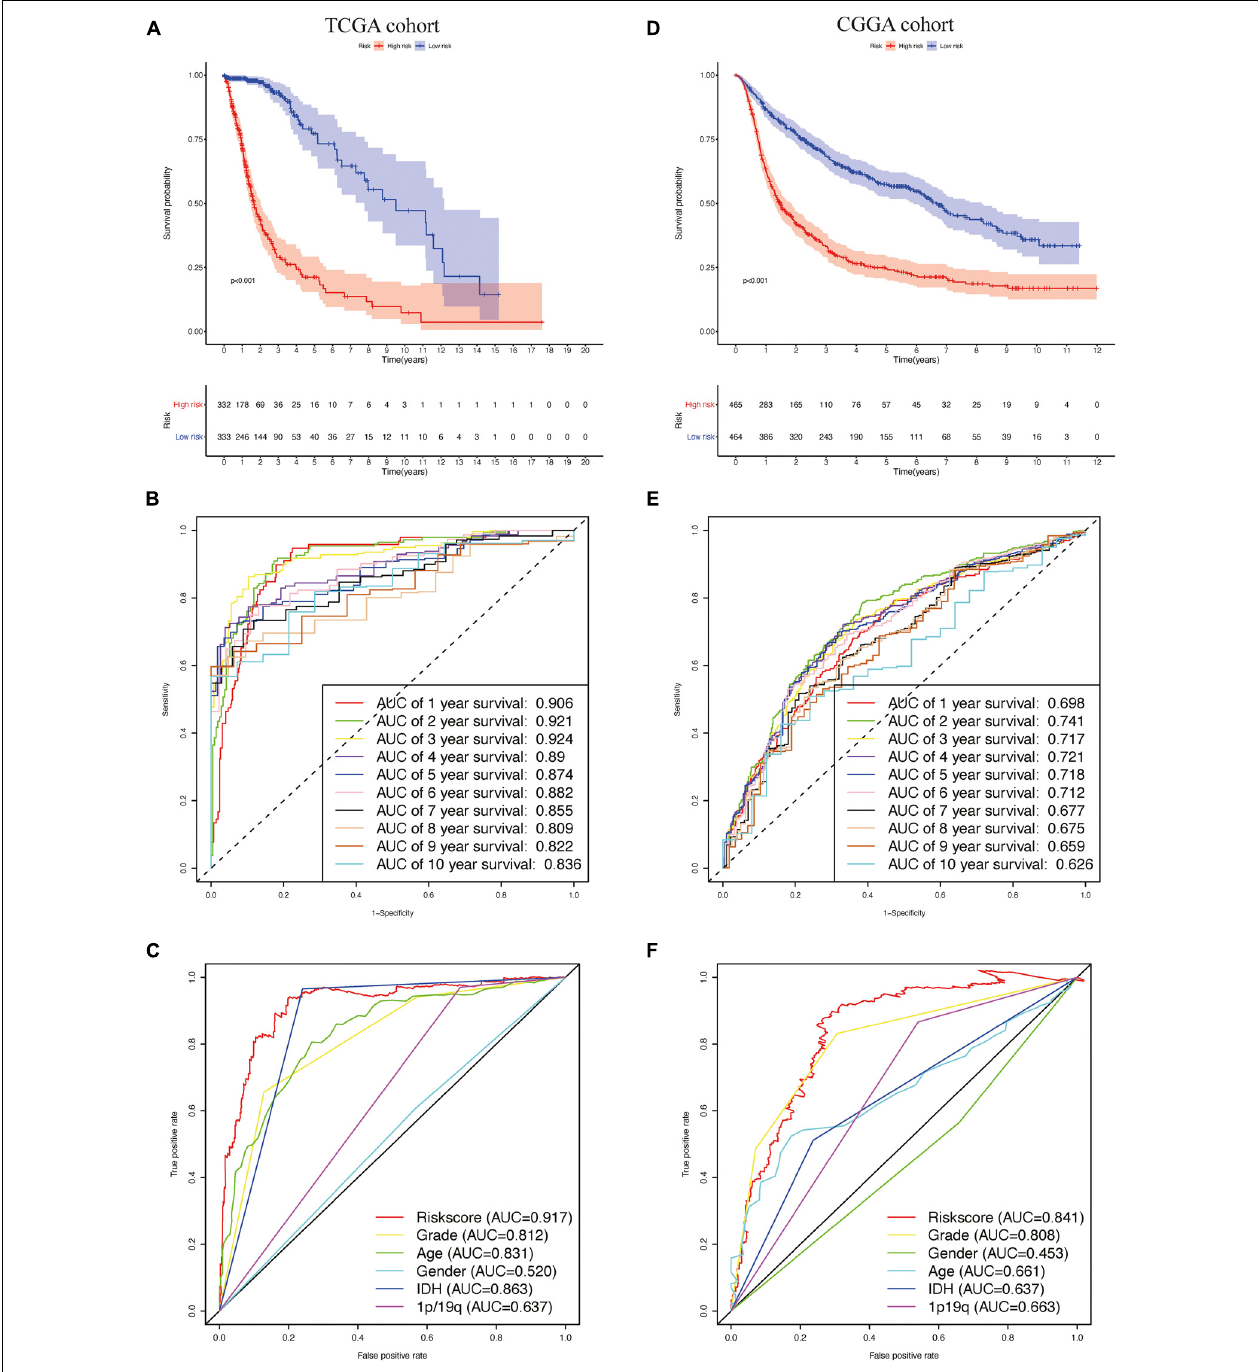
FIGURE 4 | The prognostic value of the risk signature in The Cancer Genome Atlas (TCGA) and the Chinese Glioma Genome Atlas (CGGA) cohorts. (A) Kaplan–Meier (K–M) survival analysis of the risk score in TCGA cohort. (B,C) Time-dependent receiver operating characteristic (ROC) curve analysis of the risk score and traditional factors in TCGA cohort. (D) Kaplan–Meier (K–M) survival analysis of the risk signature in the CGGA cohort. (E,F) Time-dependent ROC curve analysis of the risk score and traditional factors in the CGGA cohort.